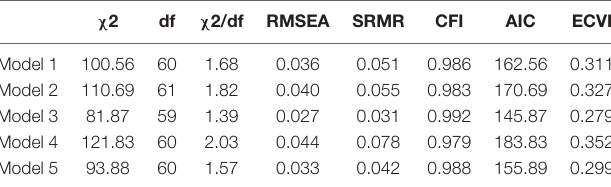
data: χ 2 = 81.87; df = 59; RMSEA = 0.027; SRMR = 0.031; and CFI = 0.992. The chi-square difference was also found significant ( (cid:49) χ 2 (1, N = 523) = 18.69, p < 0.001). Based on the comparison